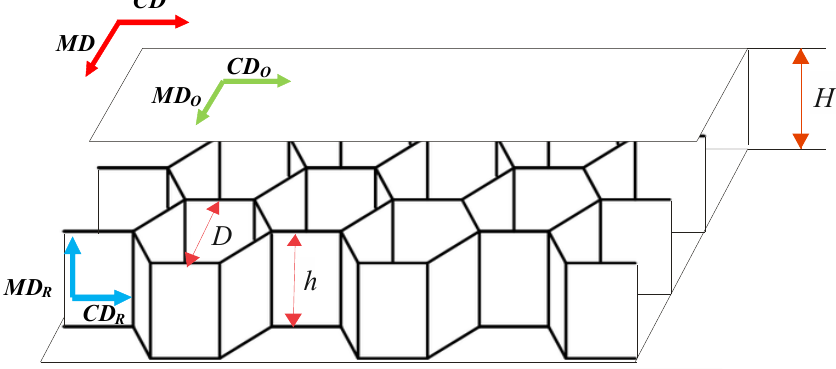
Figure 1. Cellular paperboard parameters.